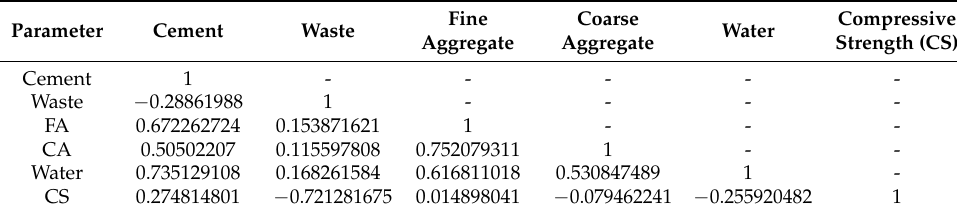
Table 6. Spearman rank correlation coefficients for the parameters in this